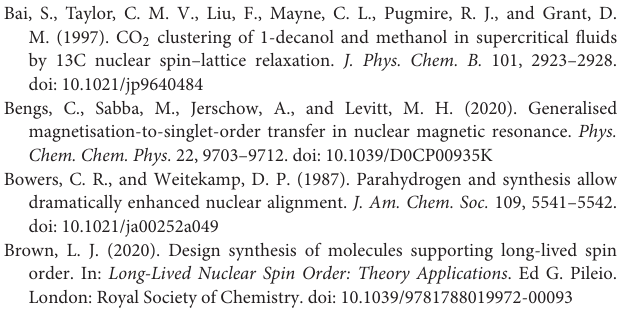
is perhaps not very convenient for